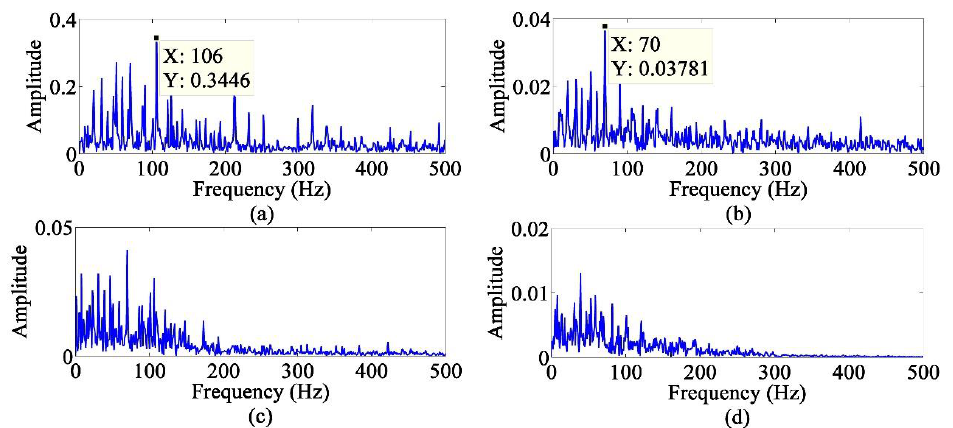
Figure 14. The Hilbert envelope spectra of each IMF after EEMD. ( a ) IMF1. ( b ) IMF2. ( c ) IMF3. ( d ) IMF4.